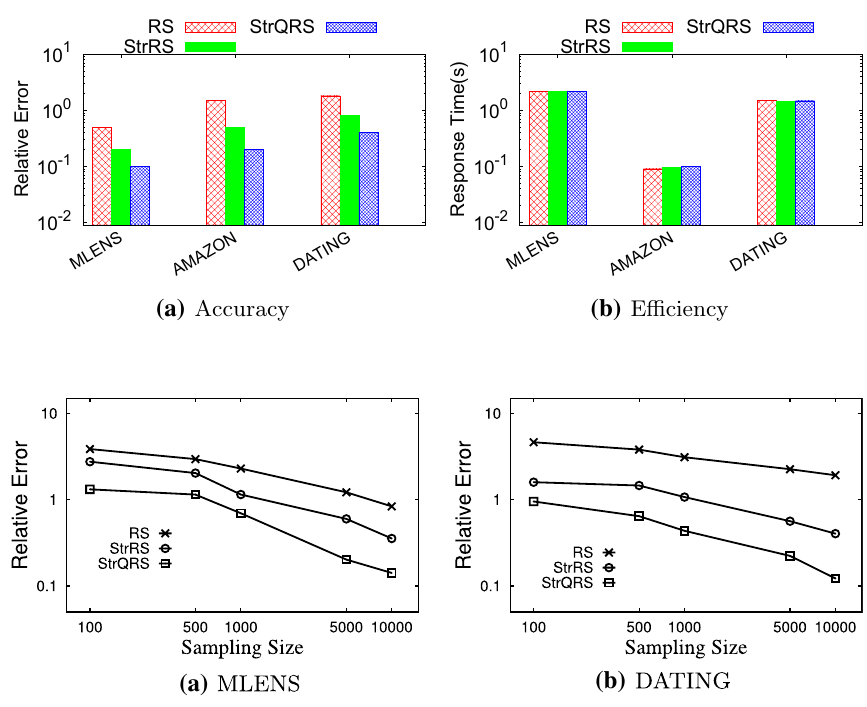
Fig. 6 Accuracy versus